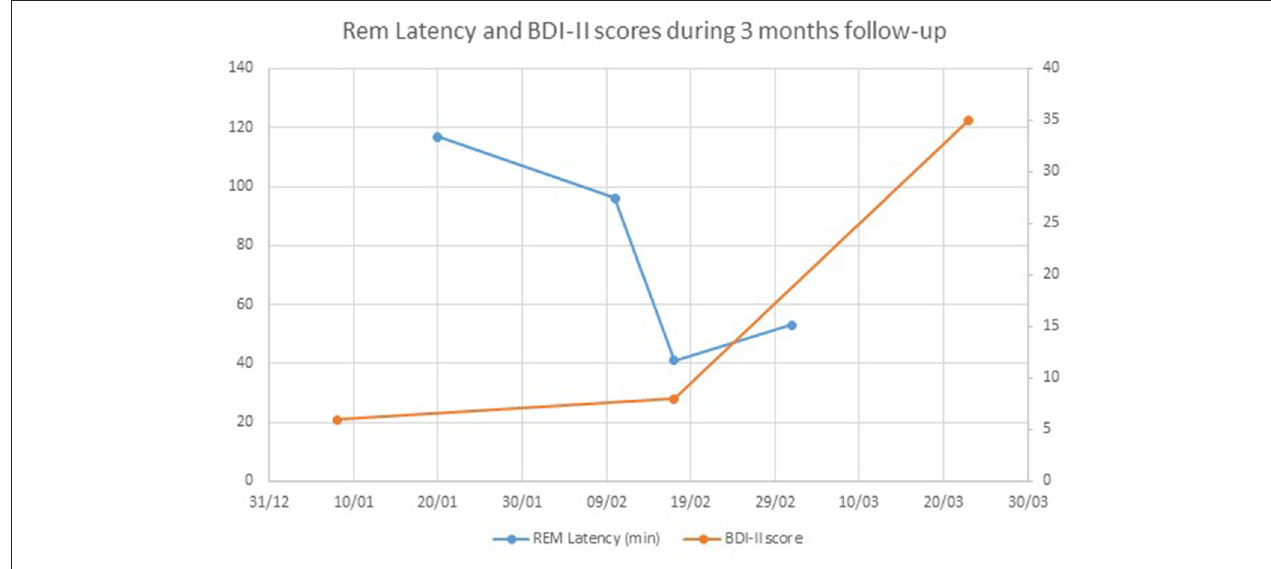
FIGURE 4 | Rem Latency and BDI-II scores during 3 month